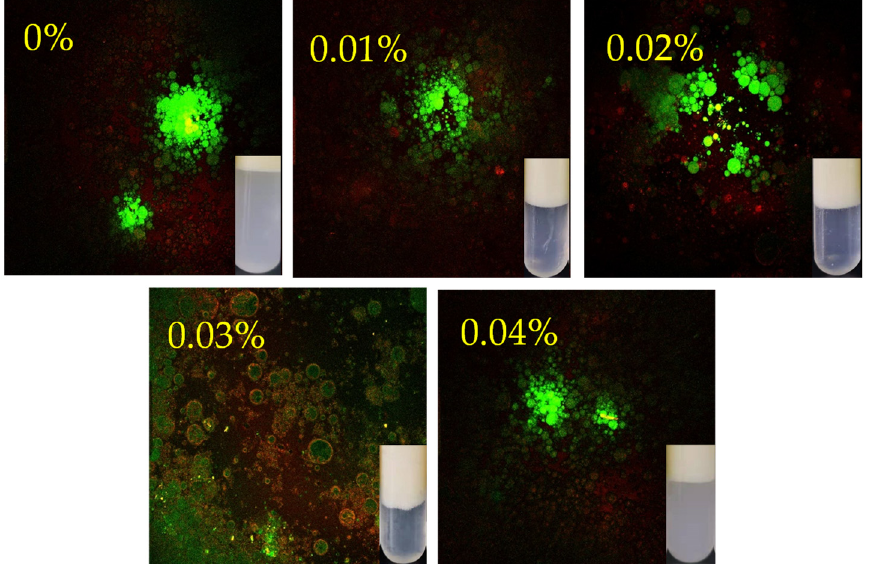
Figure 4. Changes in the confocal laser scanning microscopy micrographs and images after stabilization of wooden breast myofibrillar protein emulsions under different contents of (-)-epigallocatechin-3-gallate.